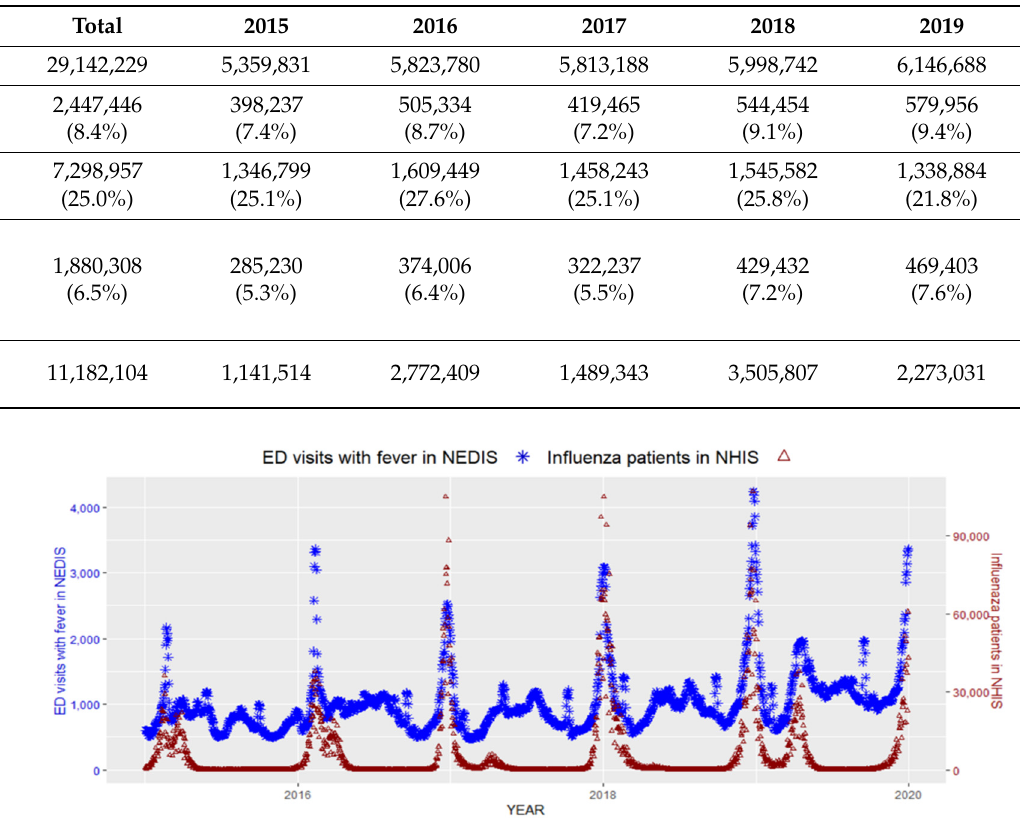
Table 1. Number of ED visits, ED visits with fever, and ED visits with final diagnosis of influenza.